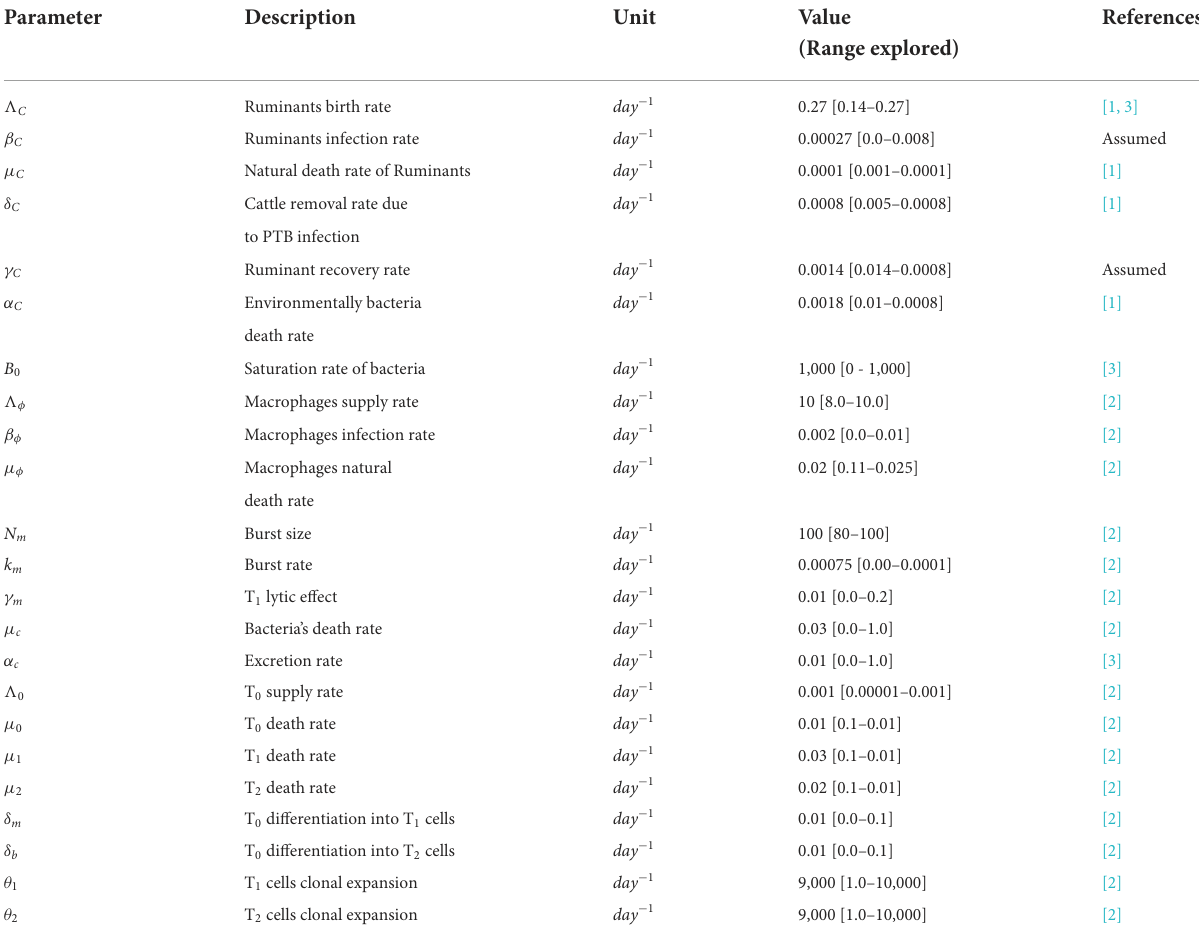
TABLE 3 Model parameter values used for